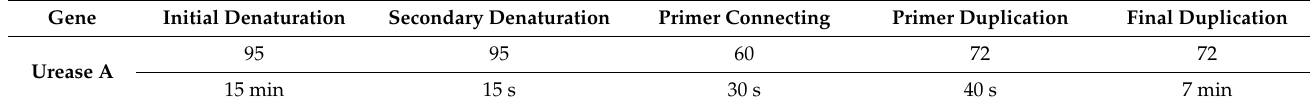
Table 4. Conditions of PCR reaction.